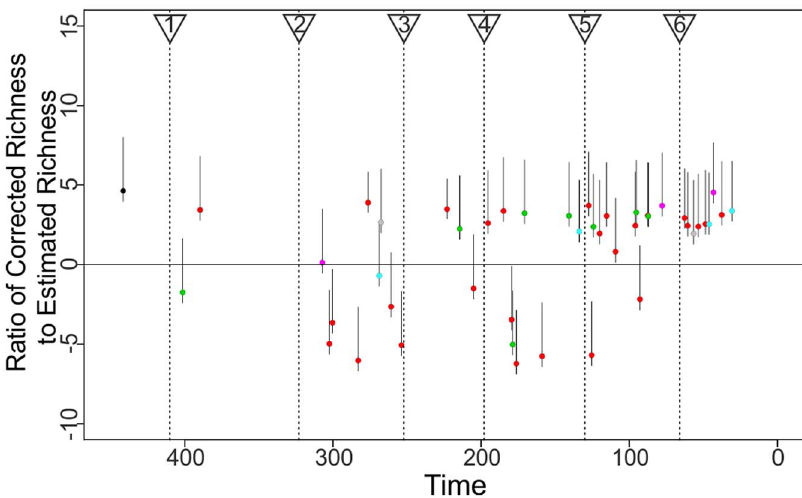
Figure 3. Change in species richness associated with shift events plotted through time. Values plotted show the ratios between the observed richness of the clade (after correction for nested shifts) and the mean estimated values of the richness of a clade of the appropriate age under the parental diversification model (see main text and Supplementary materials). Confidence intervals given are based on the change in richness associated with 95% CIs on the estimated outcomes of the stochastic diversification process. See also Table